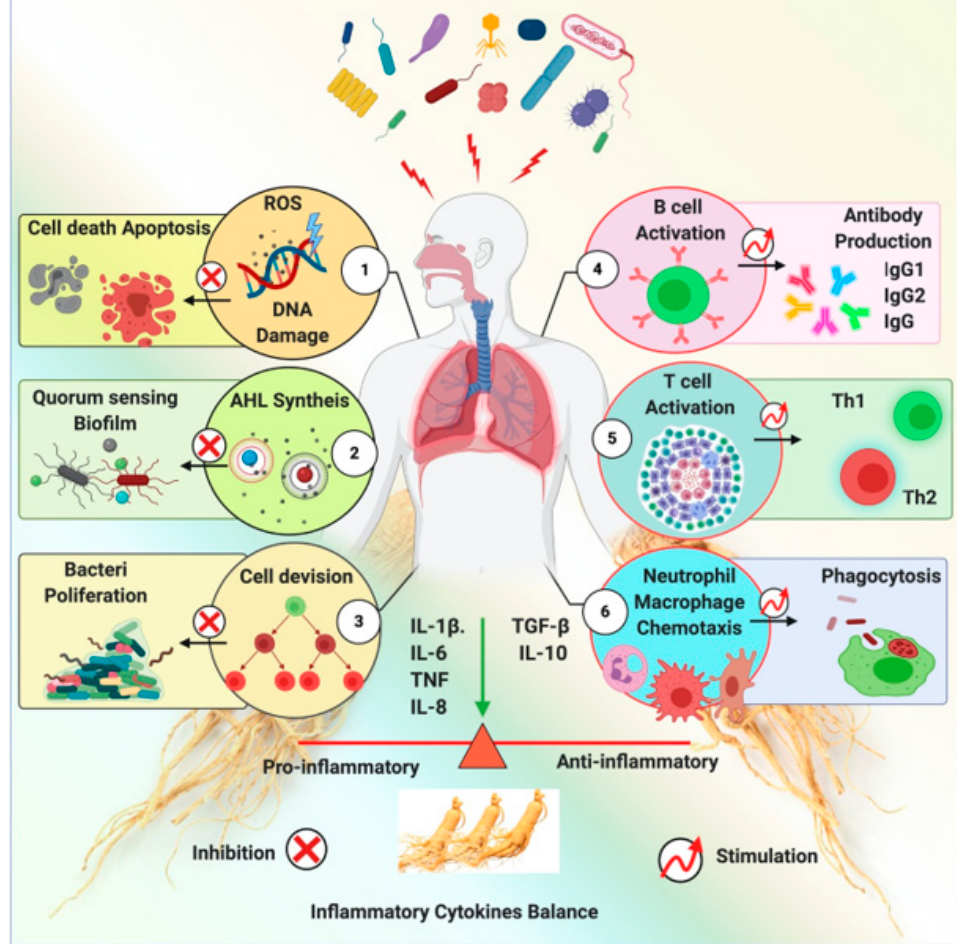
Figure 6. Ginseng and its derived components’ anti-bacterial effects via multiple mechanisms. ( 1 ) Ginseng inhibits the DNA damage and apoptosis by inhibition of ROS, ( 2 ) suppresses AHL-(acyl homoserine lactones) leading to the inhibition of quorum sensing biofilm formation of bacteria, ( 3 ) inhibits cell division and bacterial proliferation, ( 4 ) stimulates B cell activation and antibody production, ( 5 ) activates Th1 and Th2 response, ( 6 ) ginseng enhances phagocytosis of Neutrophil and macrophage [37].